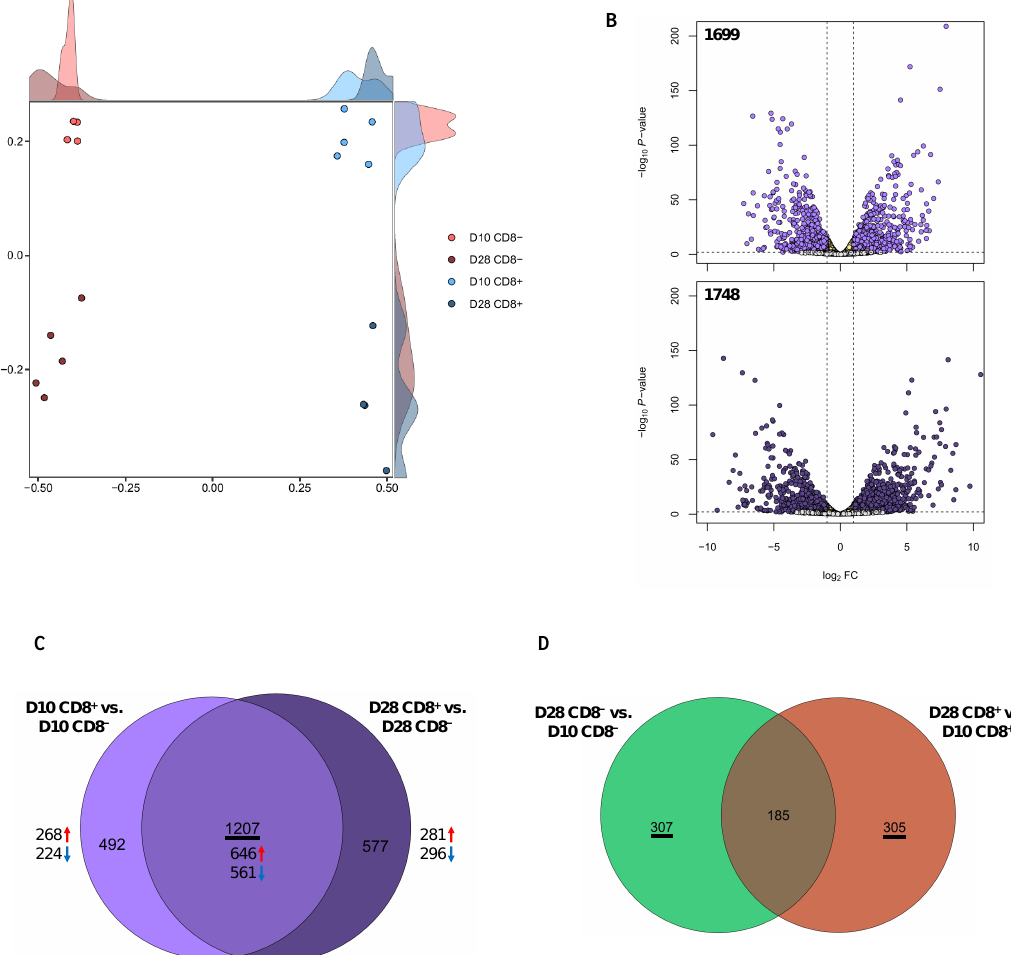
Figure 1. Transcriptomes in γδ T cells according to the involvement of CD8: ( A ) MDS revealed separate clusters among the four cell groups, based on the transcriptomes; ( B ) volcano plots of DEGs for CD8 + γδ T cells compared to CD8 − . The x and y axes of the volcano plots show the log 2 FCs and − log 10 p -values, respectively; ( C ) Venn diagrams with DEGs from D10 CD8 + vs. D10 CD8 − (light purple) and D28 CD8 + vs. D28 CD8 − (dark purple); ( D ) Venn diagrams with DEGs from D28 CD8 − vs. D10 CD8 − (green) and D28 CD8 + vs. D10 CD8 +